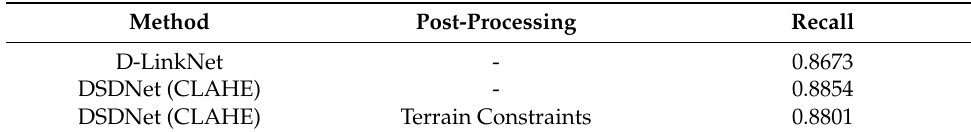
Table 3. Accuracy of different experimental models.